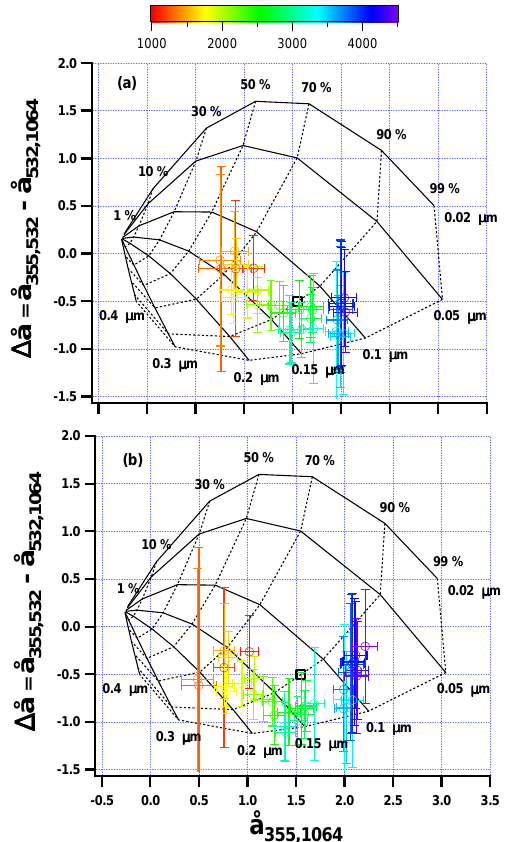
Fig. 3. Solid and dashed black lines represent the graphical frame- work calculated for n = 1.455 and k = 0.0047 at 532nm. (a) Open dots represent calculated 1 å (z) vs. å (z) values. Error bars repre- sent uncertainties. Different colours are used to represent 1 å (z) - å (z) values referring to different z , as indicated by the colour bar on the top of the figure. The full black box represents the colum- nar å in (355, 1064) and 1 å in values calculated from Eq. (4)–(5), respectively. (b) Open dots represent 1 å (z) vs. å (z) values calcu- lated from extinction profiles based on altitude-dependent lidar ratio